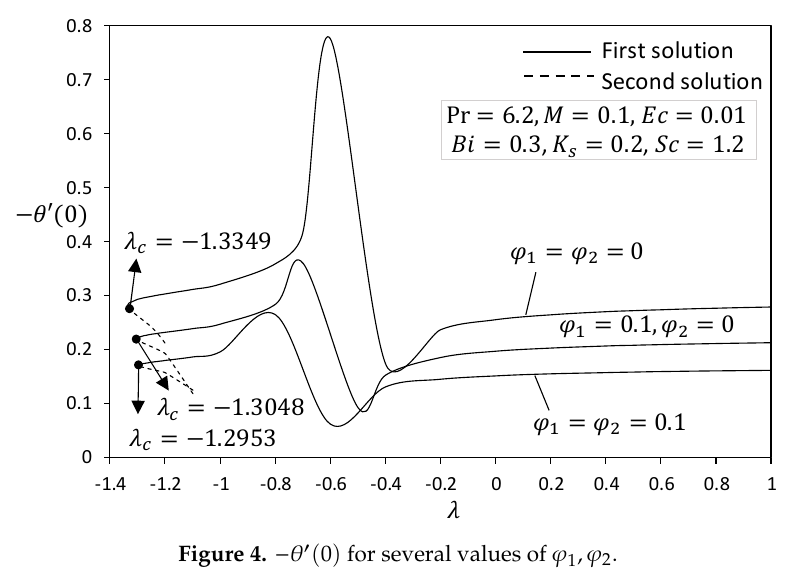
( ) Figure 3. f (cid:48)(cid:48) ( 0 ) for several values of ϕ 1 , ϕ 2 . 0 f ′′ for several values of Figure 3.